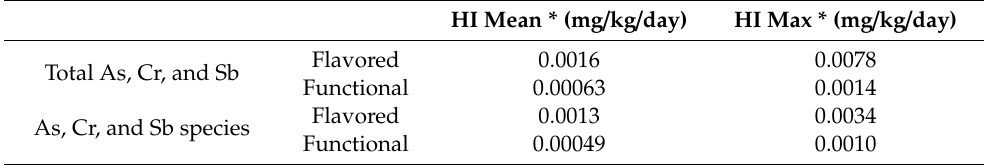
Table 3. Hazard index (HI) values for flavored and functional bottled drinking water samples estimated for mean and maximal As, Cr, and Sb, as well as As and Sb species concentrations. HI Mean * (mg / kg /